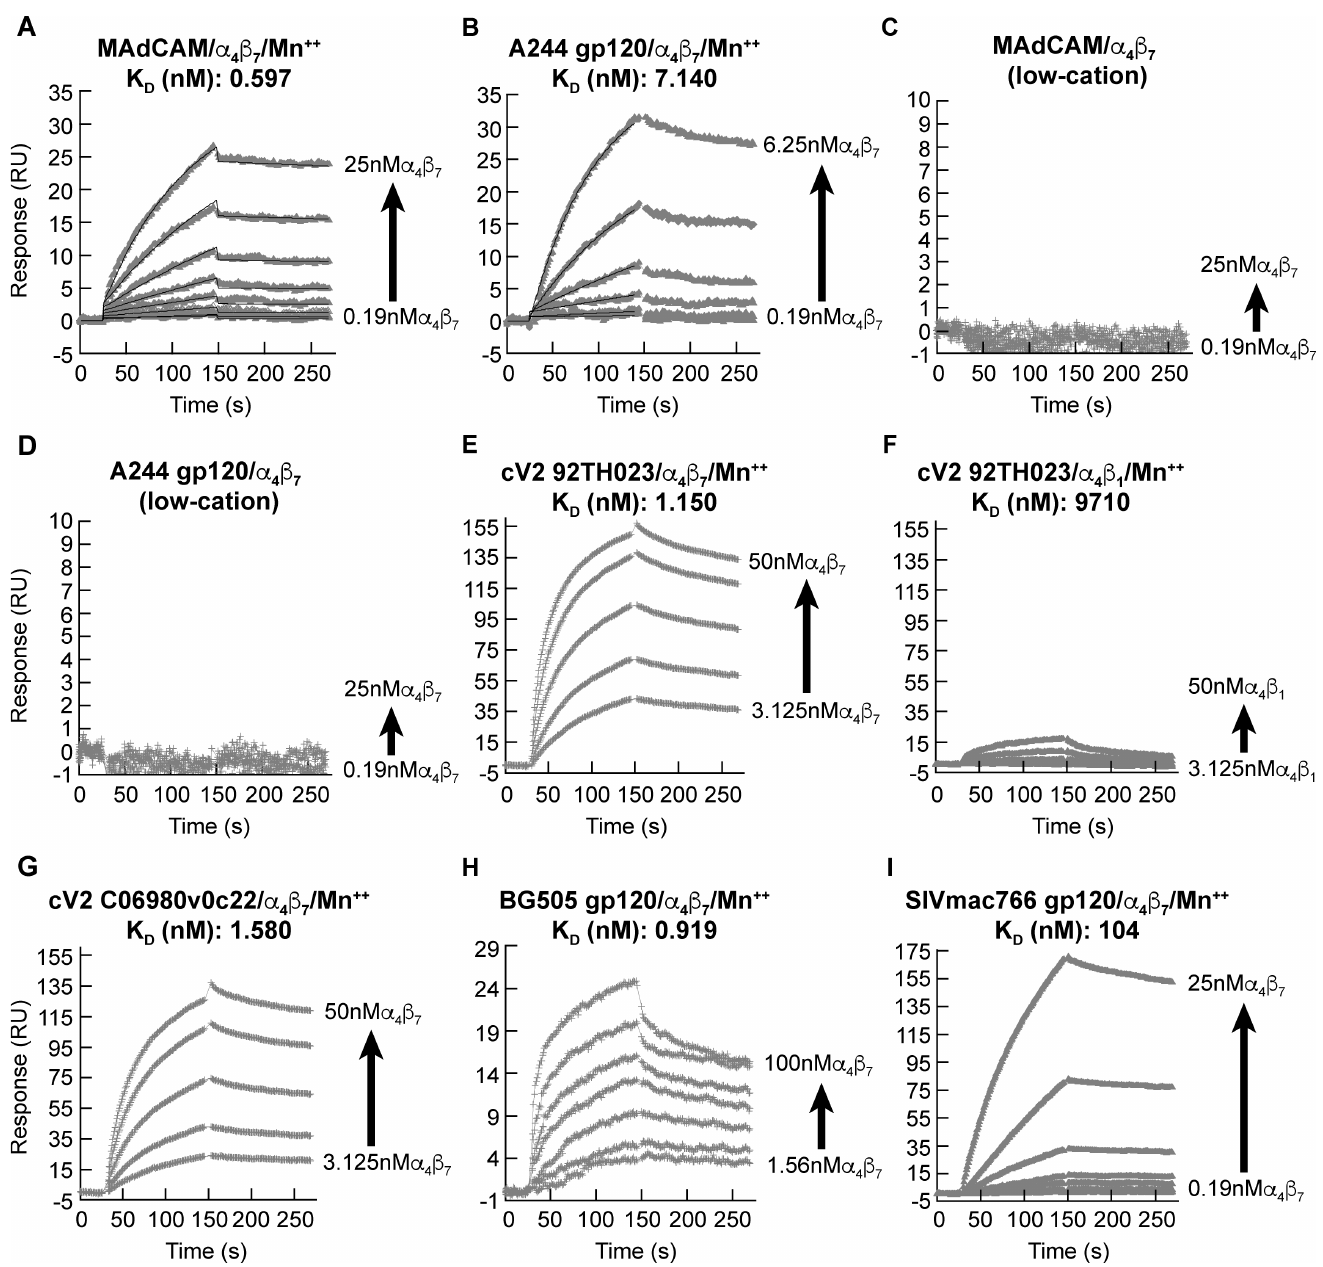
Fig 1. Specific affinity of α 4 β 7 for HIV gp120, MAdCAM and SIV gp120. A) Sensorgram of increasing concentrations (2-fold) of soluble α 4 β 7 passed over surface- immobilized MAdCAM in the presence of 1 mM MnCl 2 for 120 sec, followed by a 120 sec washout/dissociation phase. Mass of bound α 4 β 7 (y-axis) expressed as response units (RU). Affinity expressed as K D (nM) is shown. B) Same as in panel A, with immobilized A244 gp120. C) Same as in panel A with immobilized MAdCAM in the absence of divalent cations. D) Same as in panel A with immobilized A244 gp120 in the absence of divalent cations. E) Same as in panel A with immobilized cV2 92TH023 peptide. F) Same as in panel A with immobilized 92TH023 cV2 peptide and soluble α 4 β 1 as the analyte. G) Same as in panel A with immobilized cV2 C06980v0c22 peptide. H) Same as in panel A with immobilized BG505 gp120. I) Same as in panel A with immobilized SIVmac766 gp120. Additional binding parameters are listed in S1 Table. Each sensorgram is representative of three independent measurements of each analyte-ligand interaction. https://doi.org/10.1371/journal.ppat.1007278.g001 with MAdCAM by binding to key residues in the ligand binding groove formed by the inter- face between α and β (Fig 2A). Vedolizumab is a mAb antagonist of α with a different and 4 7 4 β 7